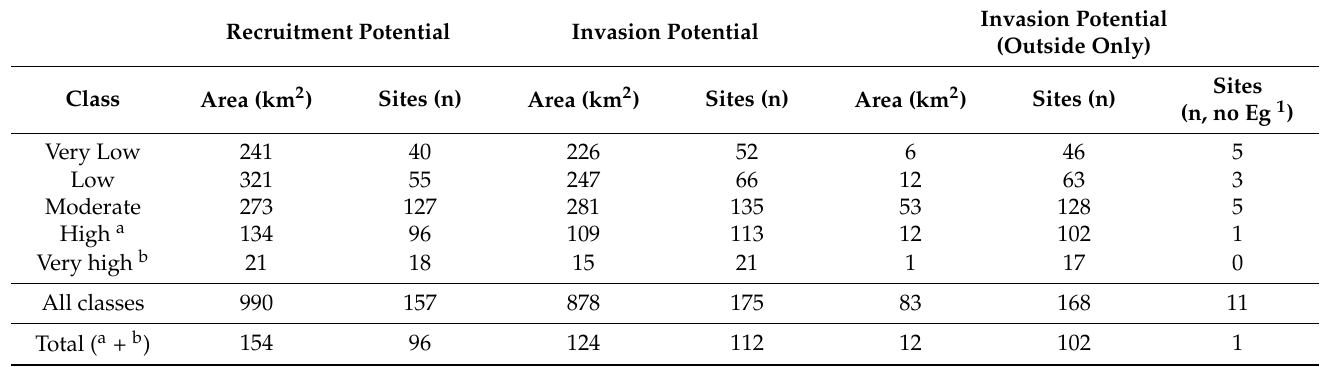
Table 4. Areas (km 2 ) and number of sites from the Natura 2000 network according to levels of recruitment potential and invasion